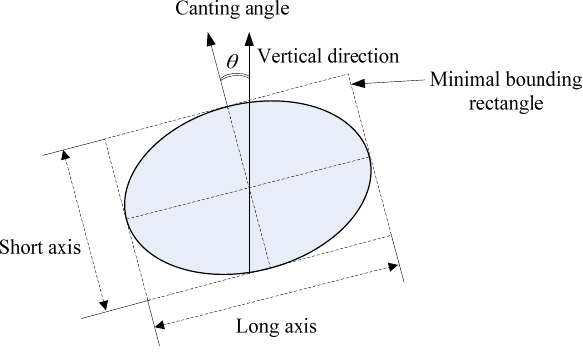
Figure 6. Minimal bounding rectangle of raindrop image and orientation angle.